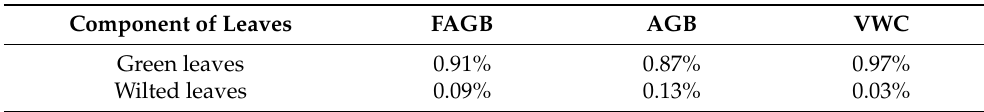
Figure 11. The canopy parameter characteristics of the green and wilted leaves in the LAI comparison during the whole growing season. ( a ) The FAGB, ( b ) AGB, and ( c ) VWC. Table 7. The contributions of the green and wilted leaves of maize to the FAGB, AGB and VWC, respectively.